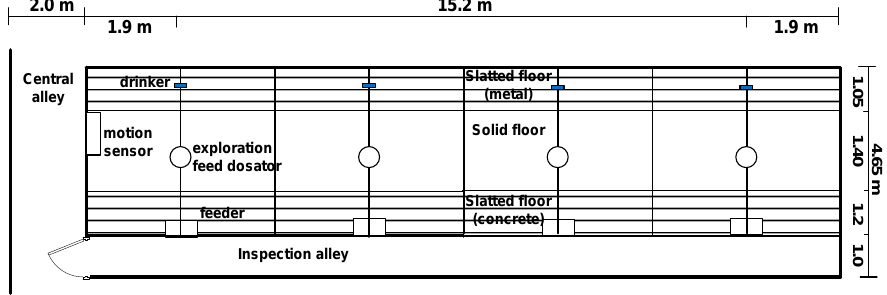
Figure 1. Layout of one of the nine rooms with eight pens with motion sensors and dosators.